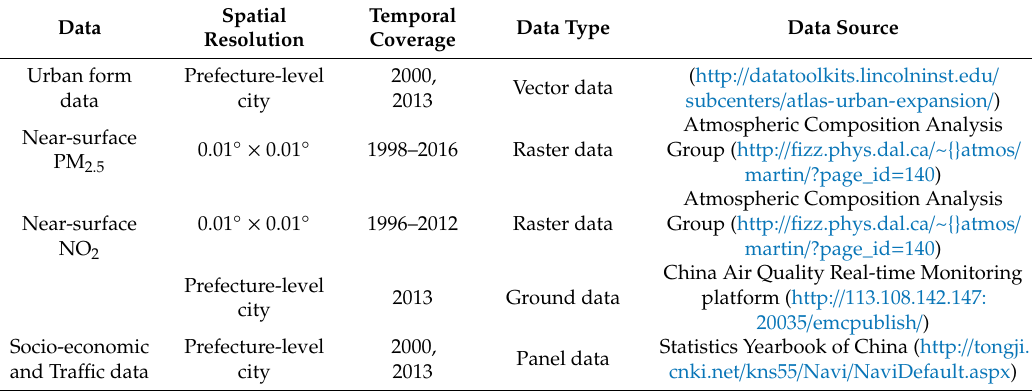
Table 1. Data sources and